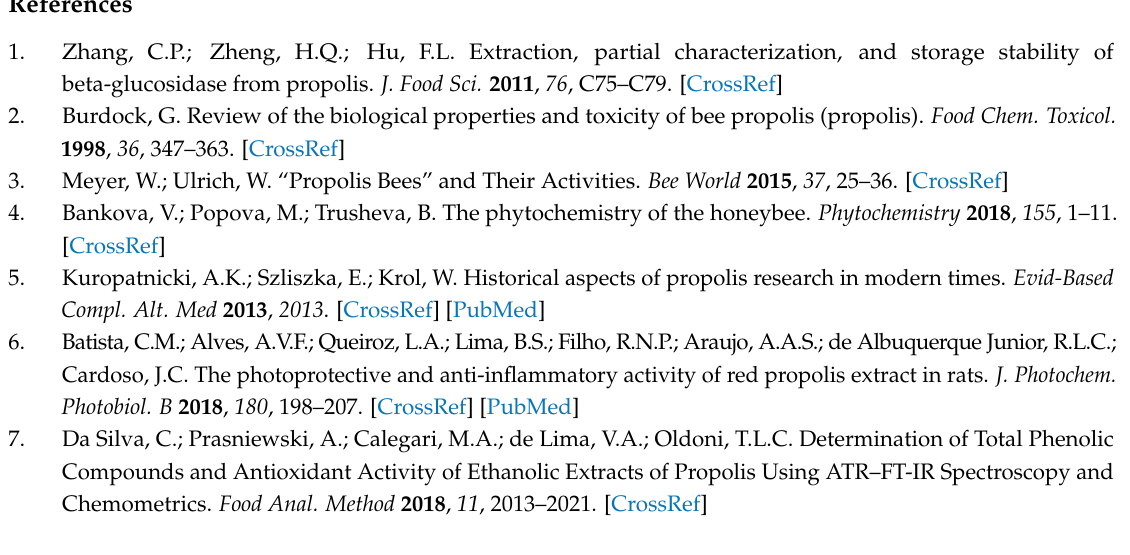
Supplementary Materials: The following are available online. Figure S1: The HPLC chromatograms of the bud and tender leaves extracts of Betula platyphylla Suk.(S1), Salix matsudana Koidz.(S2), Phellodendron amurense Rupr.(S3), Pinus densiflora Sieb.et Zucc.(S4) and standard solution (S0); Figure S2. Structures of benzyl p -coumarate; Table S1. The content of common compounds in different CBM